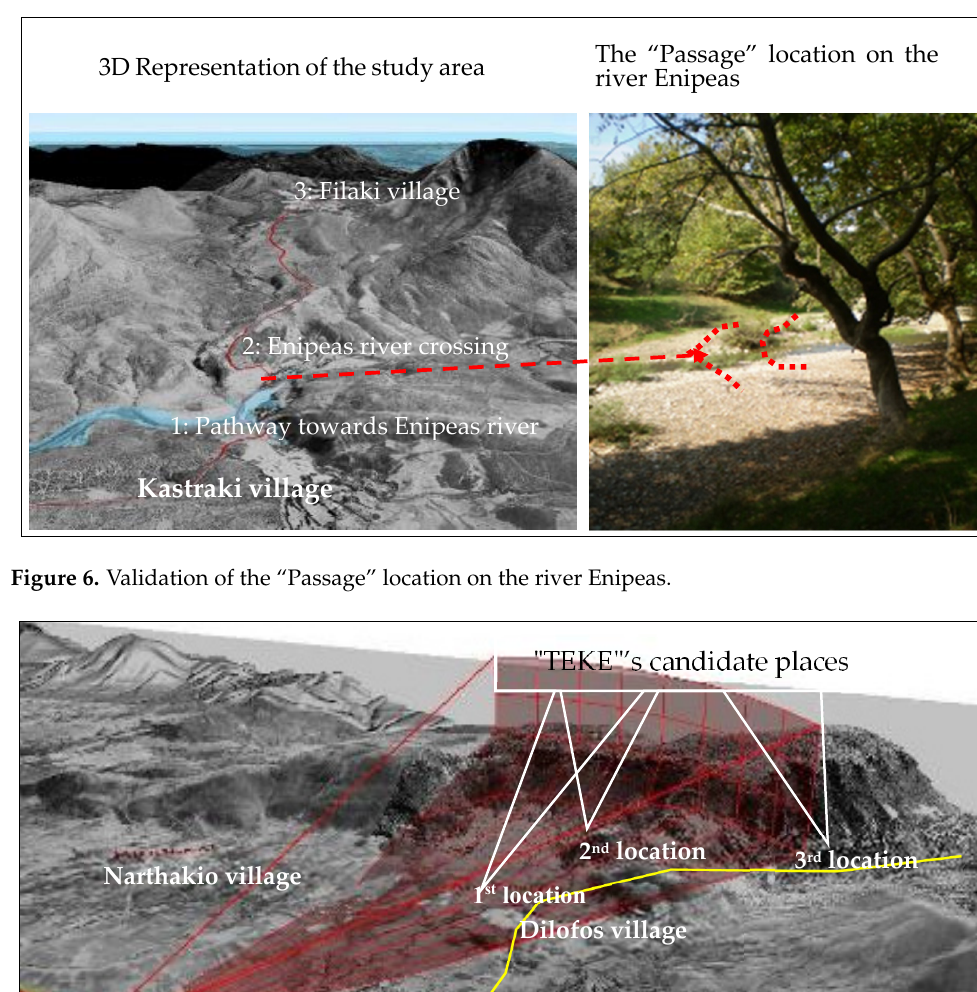
Figure 7. Visibility analysis and the 3 possible locations of the “Tekke”.